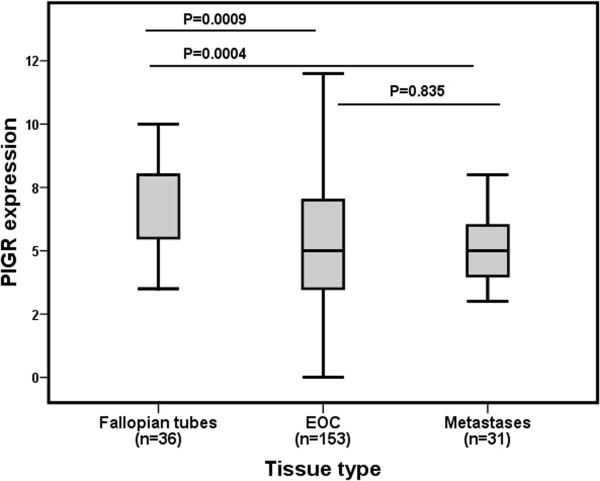
Distribution of PIGR expressions in fallopian tubes, primary tumours and metastases. Box plot visualising the staining distribution of PIGR in fallopian tubes, primary tumours and metastases. PIGR expression is described as cytoplasmic score, i.e. a multiplier of fraction (0-4) and intensity (0-3) of staining.